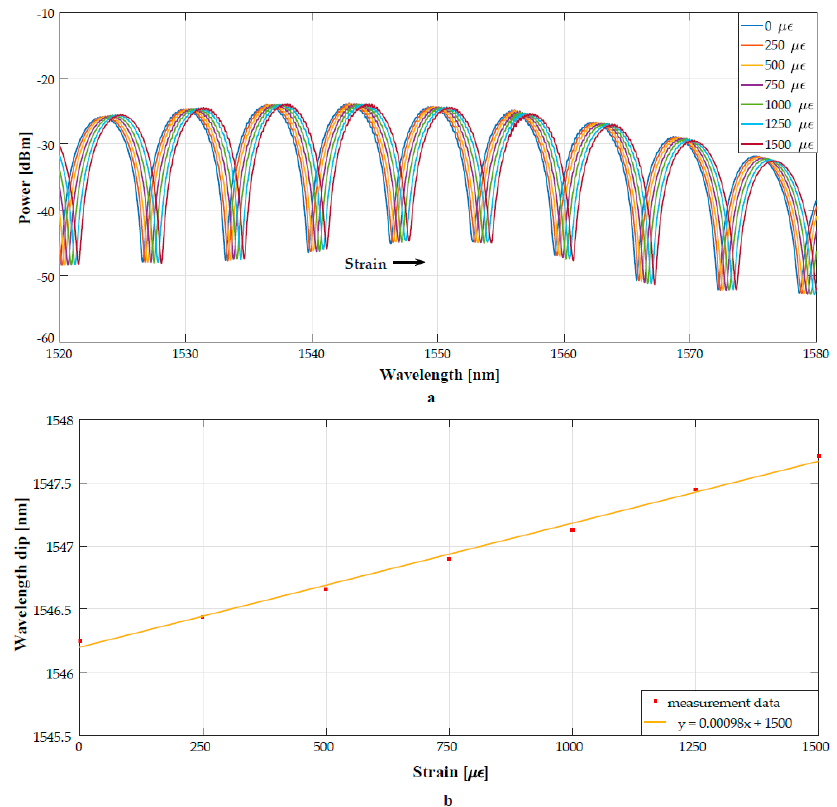
Figure 4. ( a ) The interferometer spectrum shift due to strain, ( b ) the strain response of a selected wavelength dip from the interferometer.